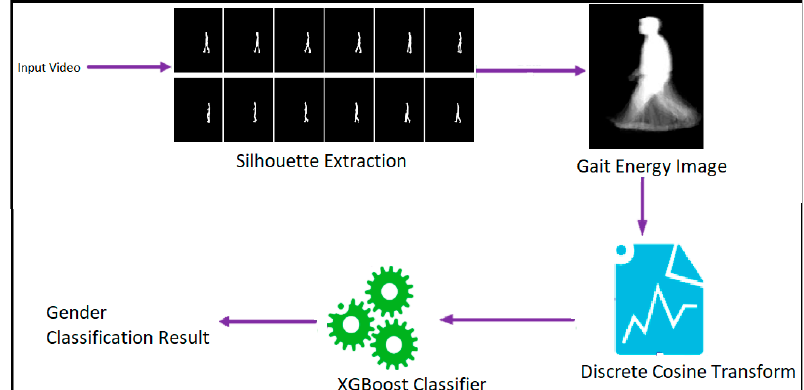
Figure 1. Proposed system for gait-based gender classification.